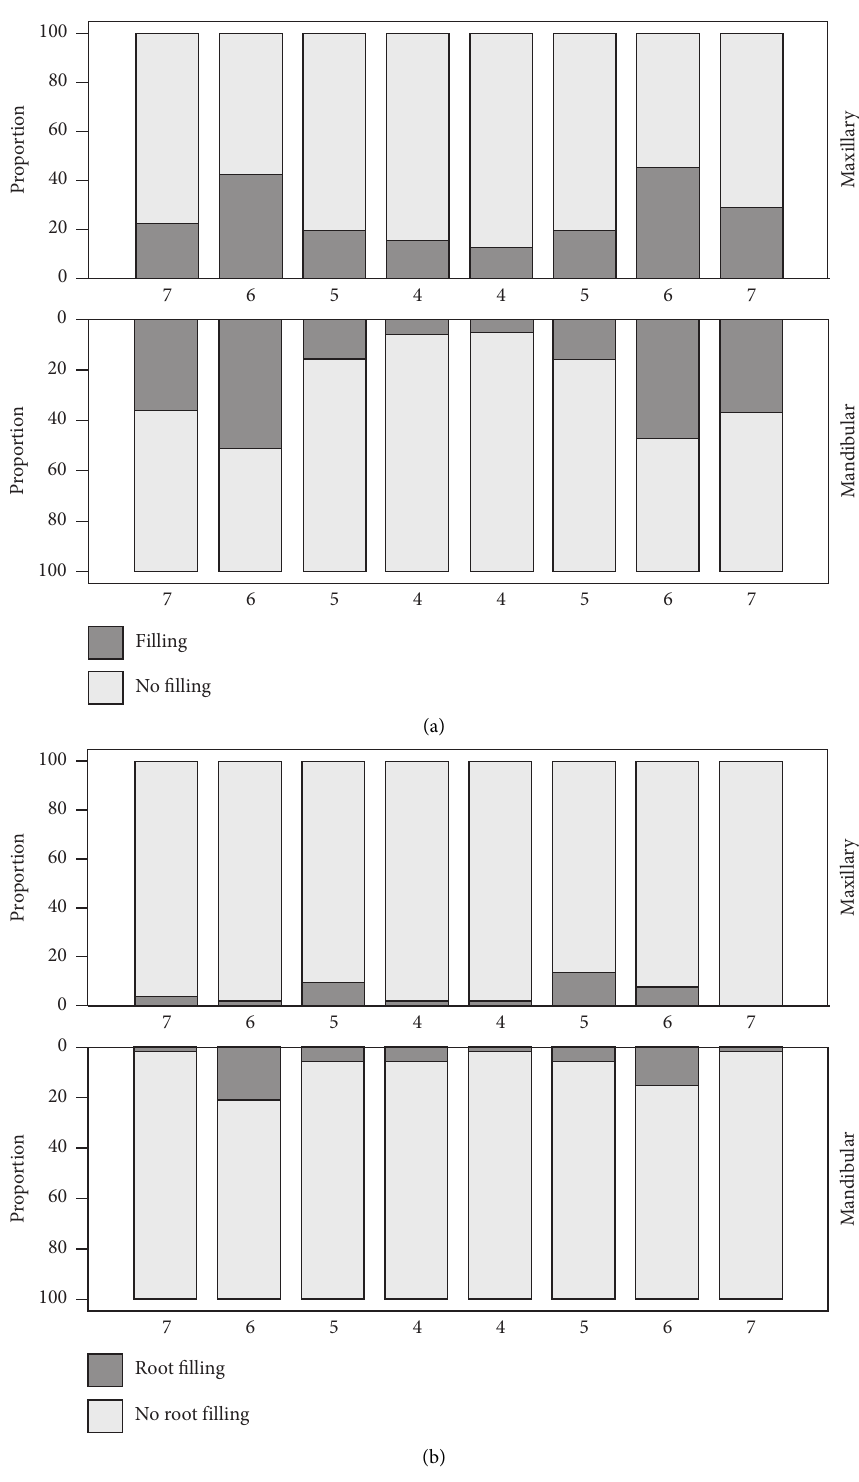
Figure 3: Distribution of fillings (a) and root fillings (b) in maxillary and mandibular premolars and